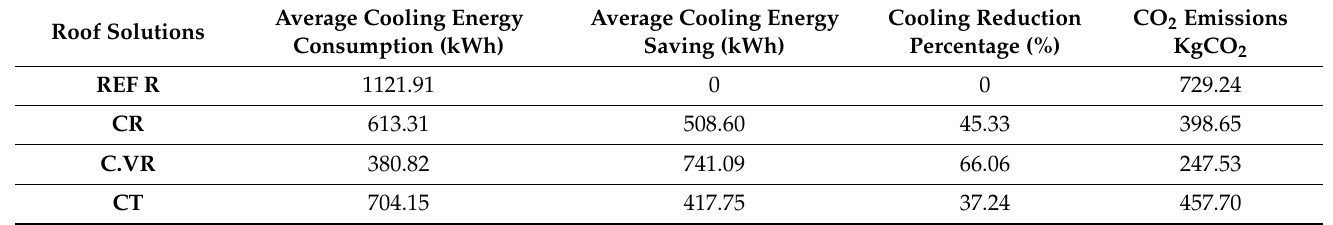
Figure 13. Average monthly cooling energy consumption of all roof solutions compared with the base case. Table 5. Monthly cooling energy consumption, cooling energy saving and CO 2 emissions relating to the studied roofing systems.